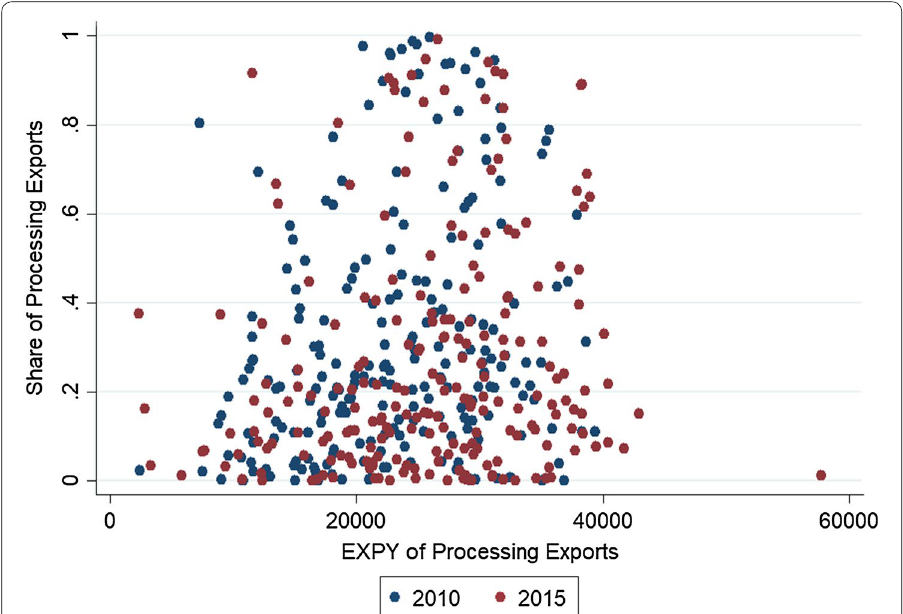
Fig. 7 Share of processing exports sorted by EXPY of processing exports. Inversed U-shaped implies that varieties exported by processing trade is not that innovative but quite sophisticated product to China. Source